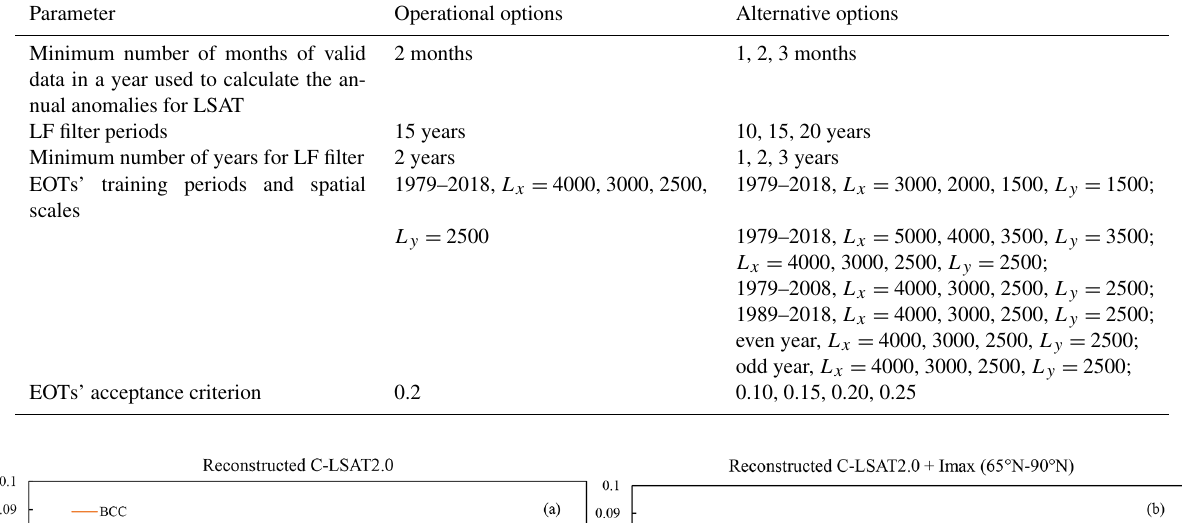
Table 1. Parameter settings used for reconstruction scenarios and the operational option.